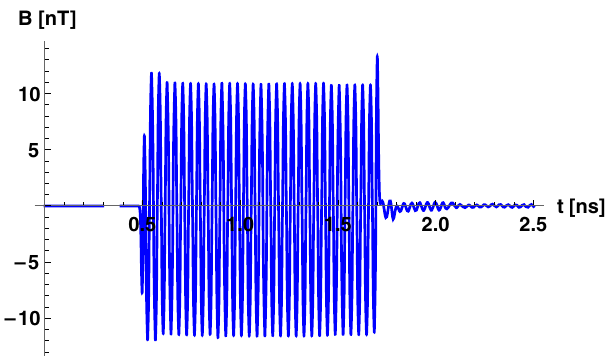
FIG. 3. Time domain magnetic field of the radiation recorded at a point P visible of Fig. 2(b) and located 10 cm away from the exit face of the dielectric.